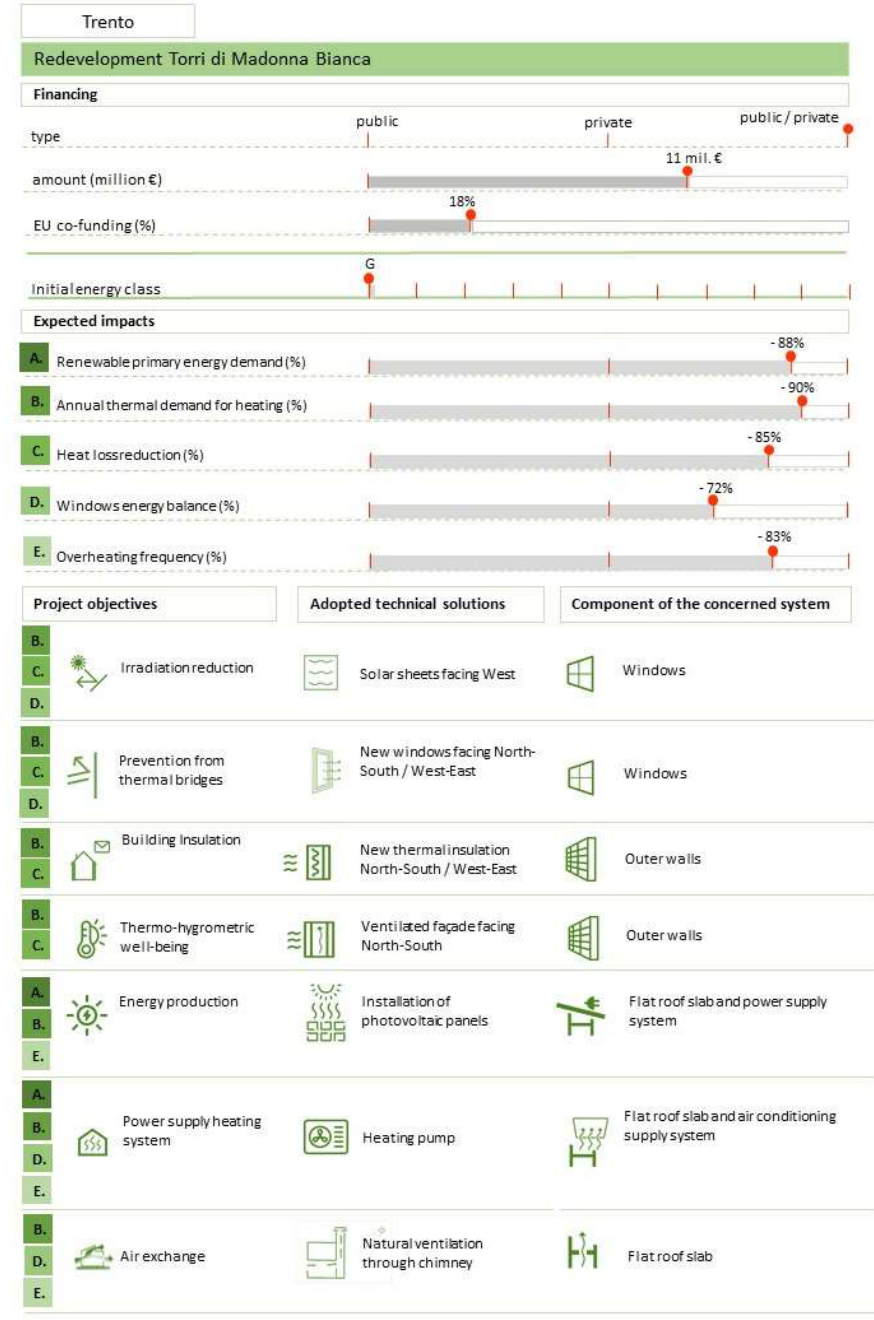
Figure 7. Trento case study project intervention: the technological solutions.